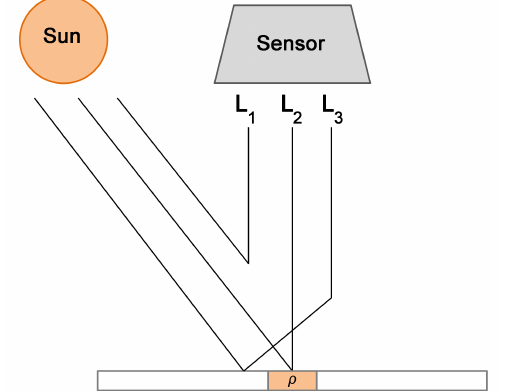
Schematic of the three solar radiation components in flat terrain and the pixel under consideration ( ρ ). Scattered or path radiance L reflected from the local neighbourhood (adjacency effect) L